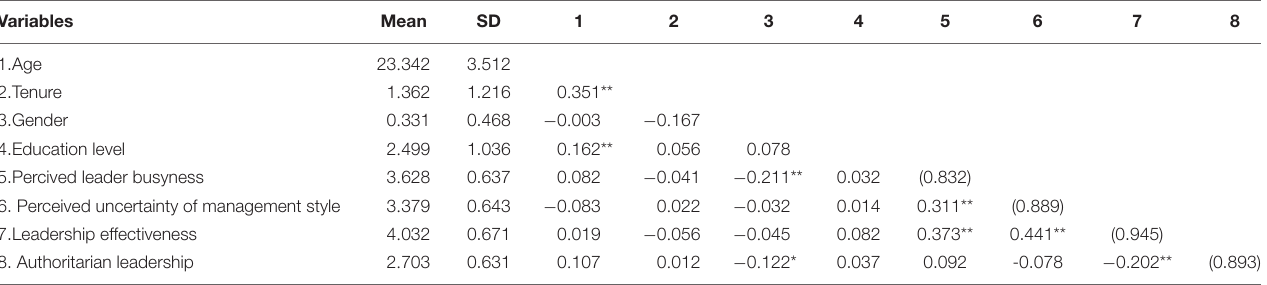
TABLE 4 | The correlations between perceived leader busyness and related